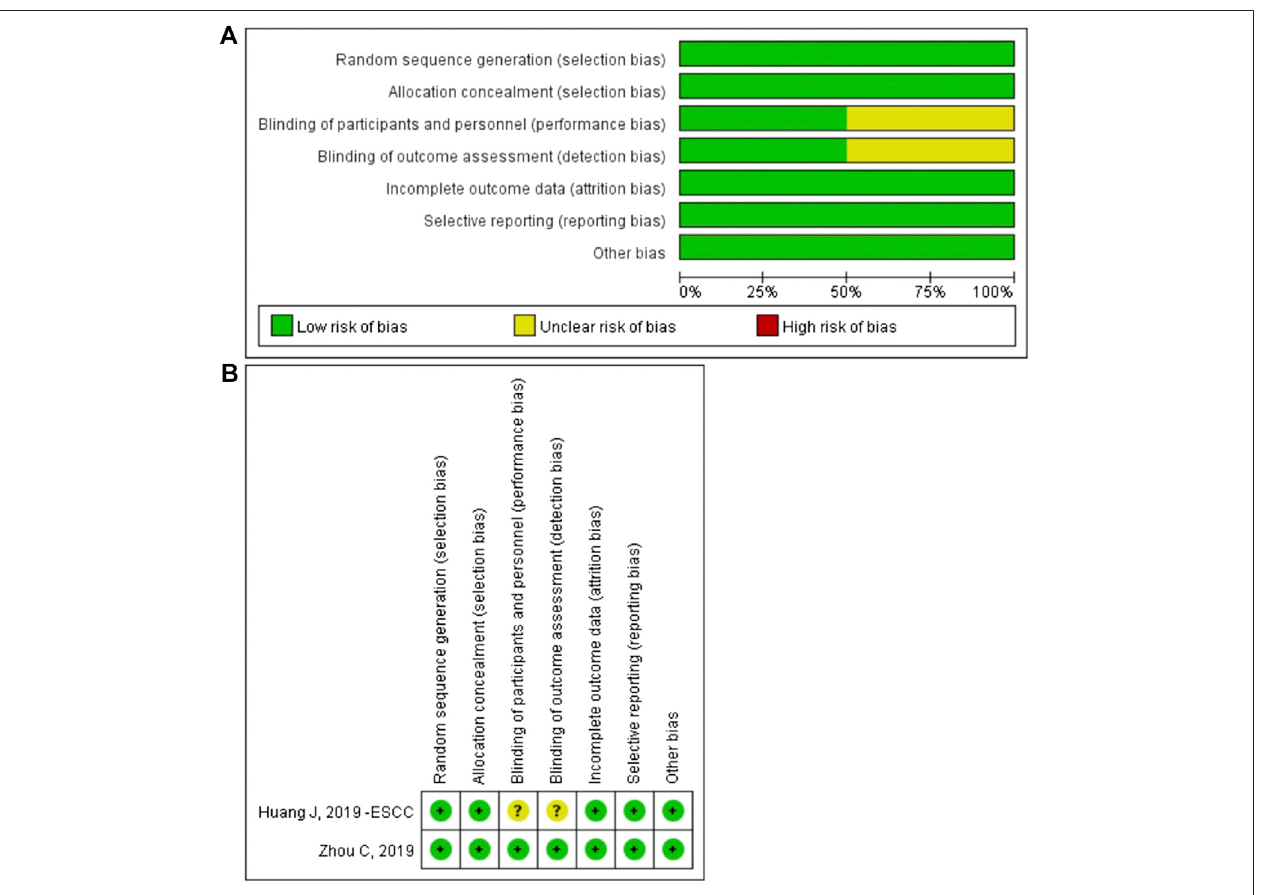
FIGURE 8 | The risk of bias graph (A) and the risk of bias summary (B) .The overall risk of bias was evaluated as low risk.